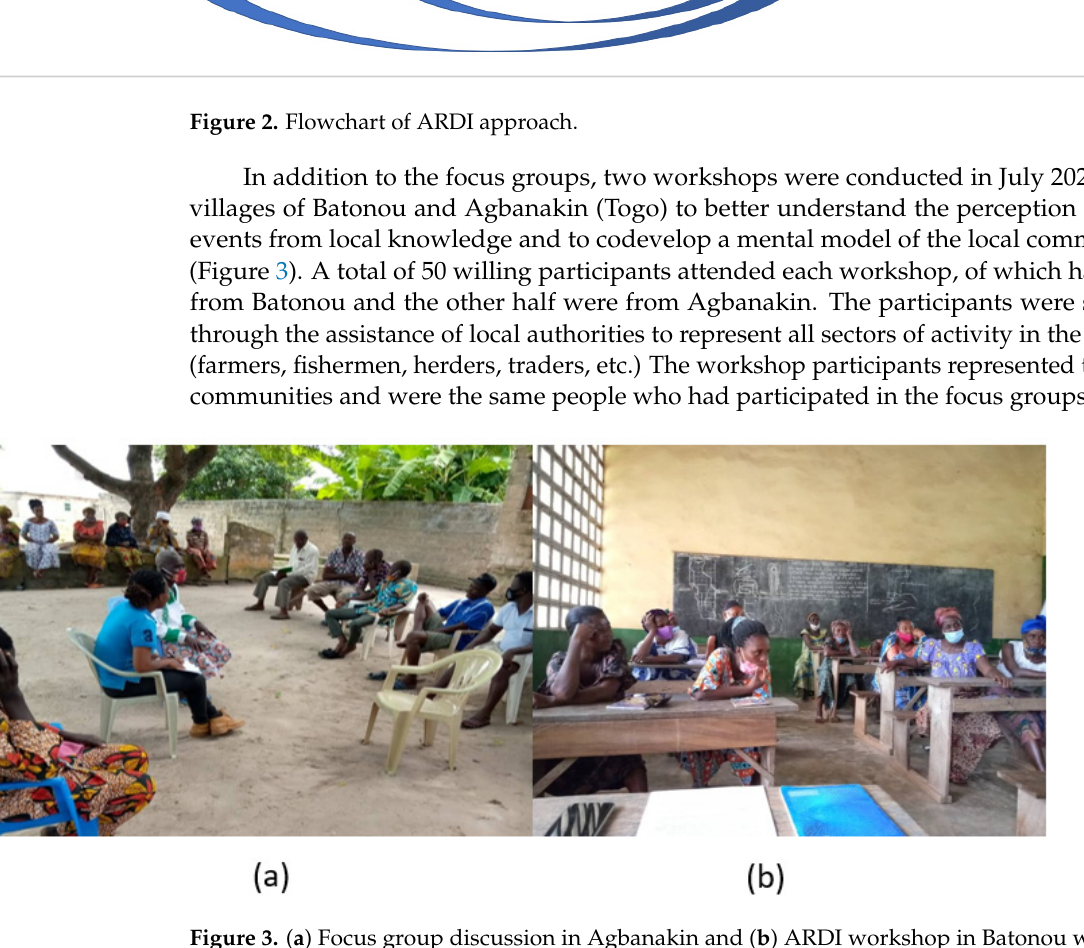
Figure 2. Flowchart of ARDI approach.